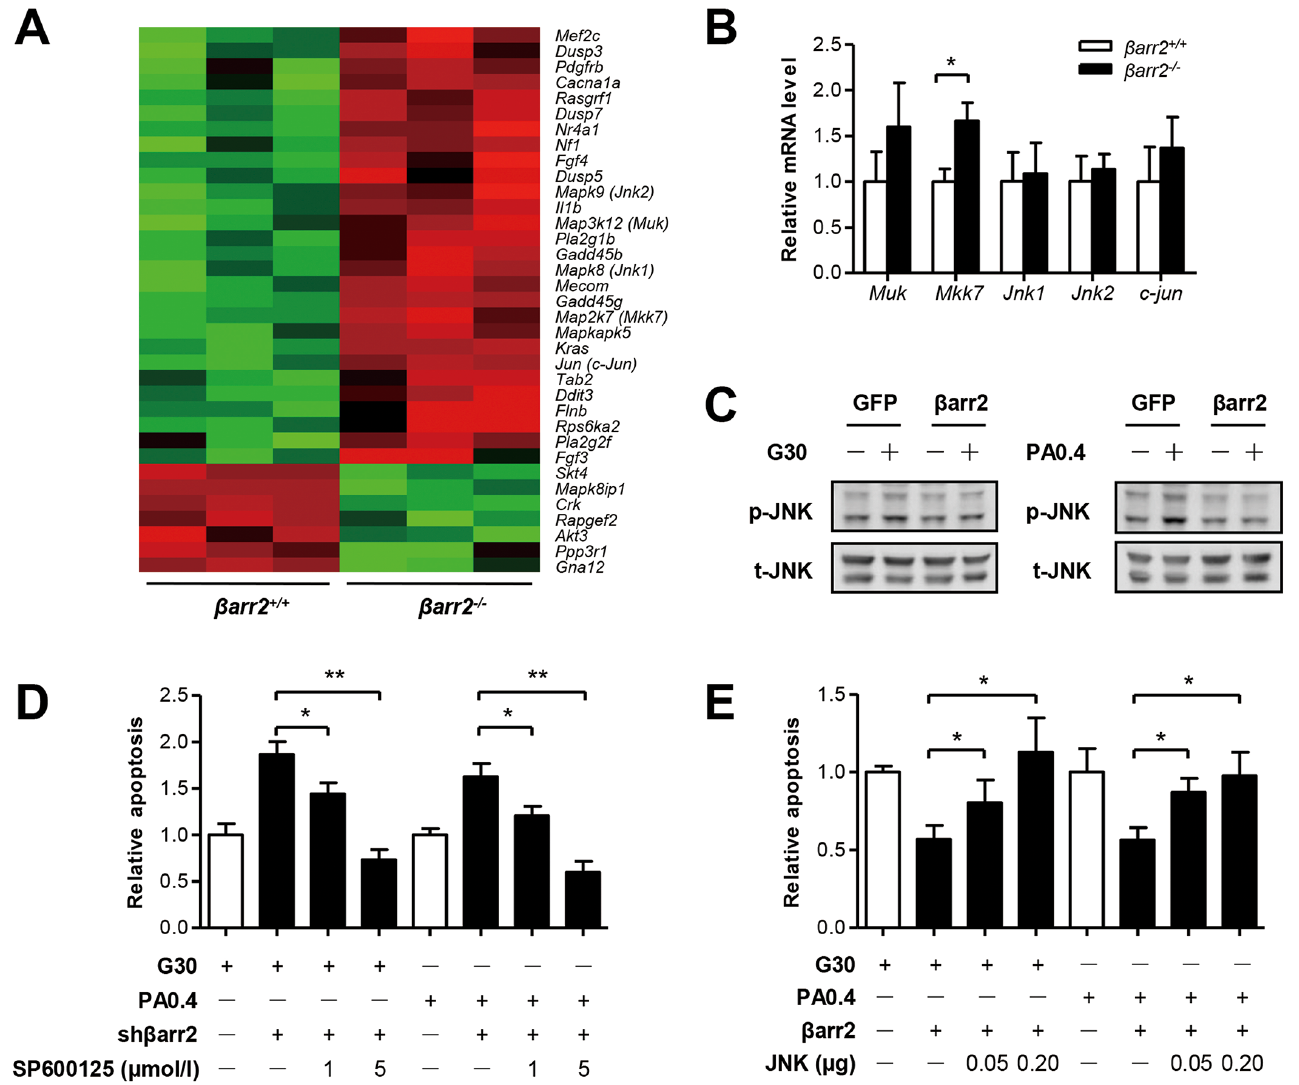
Figure 6. β arr2 inhibited FFAs or glucose-induced activation of the JNK pathway in β -cells. (A) Total RNA was obtained from islets of b arr2 +/+ and b arr2 –/– mice and subjected to whole-genome expression profiling using Affymetrix arrays. Heat diagram depicting genes in the JNK/ MAPK pathway for which expression was significantly upregulated (28 genes) and downregulated (7 genes) in the islets of b arr2 –/– as com- pared with b arr2 +/+ animals (n = 3). (B) Quantification of islet mRNA expression in the JNK pathway normalized with β -actin (n = 4–6). (C) INS-1 (832/13) cells were infected with adenovirus encoding GFP or b arr2 and assayed for p-JNK and total JNK expression in the presence or absence of 30 mmol/L glucose (G30) and 0.4 mmol/L palmate (PA0.4) for 24 h. Pictures are representative of four independent experi- ments. (D, E) INS-1 (832/13) cells were infected with either adenovirus-encoding shRNA of b arr2 (sh b arr2 ) (D) or b arr2 (E) and incubated with G30 or PA0.4 in the presence of SP600125 (D) or plasmid-expressing JNK (E). Data were presented as fold-change over cells infected with scrambled shRNA (D, white bar) or GFP (E, white bar) (n = 4). * P < 0.05, ** P < 0.01, versus indicated group. Muk , mitogen-activated protein kinase upstream protein kinase; Mkk7 , mitogen-activated protein kinase kinase 7. Jnk , c-Jun N-terminal